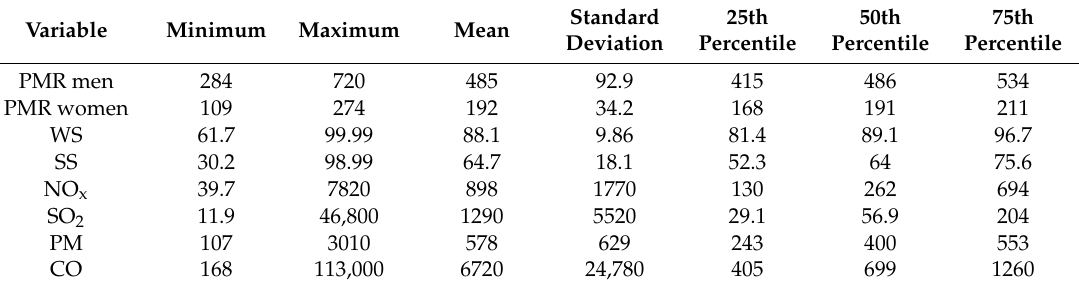
Table 1. Descriptive statistics of